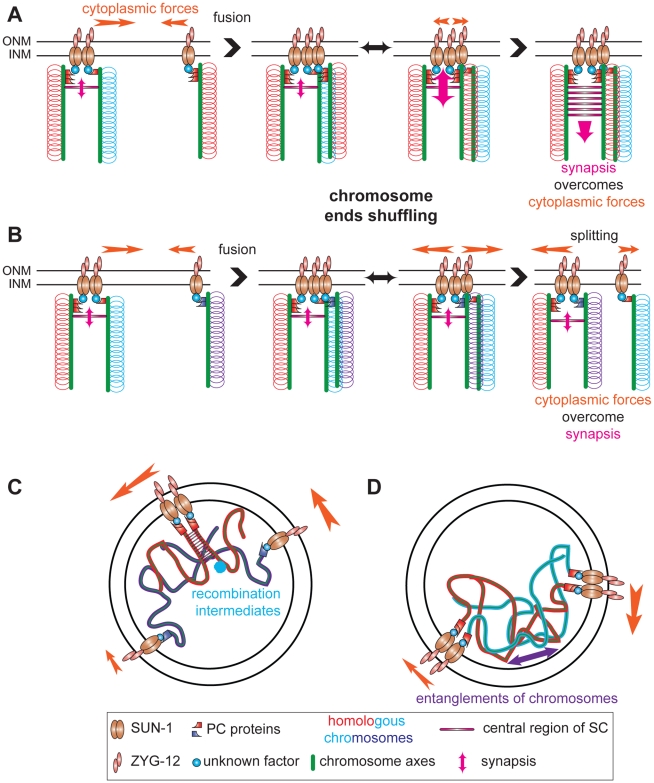
Establishment of synapsis and formation of high speed via shuffling of chromosome ends through SUN-1 patches.Chromosome axes (green lines) support binding of PC proteins (red or violet shapes) that connect chromosome ends (red, blue, and violet loops) to SUN-1 (brown ellipses), directly or indirectly, (unknown factor, blue circle). ZYG-12 (pink ellipses) and SUN-1 bridge chromosomes to cytoplasmic forces (orange arrow) to move chromosome ends. (A) SUN-1 patch containing two nonhomologous chromosome ends (red and blue loops) fuses with SUN-1 focus carrying a single chromosome end, a homolog (red loops). After fusion, chromosome ends will be shuffled inside the newly formed SUN-1 patch. When the homologous chromosome is found, synapsis overcomes the cytoplasmic forces and synapsis can be established. (B) The same scenario is depicted, except that ends of nonhomologous chromosomes are in the SUN-1 aggregate (violet loops). After fusion, chromosome ends will be shuffled. However, as the cytoplasmic forces overcome the attempt to synapse, one SUN-1 focus will be driven out of the patch. This tension-generated splitting event is one of the factors leading to the formation of high speed in the distribution of SUN-1 aggregates. Our data support other factors as sources for the high speed aggregates: recombination intermediates (C) and chromosomes entanglements (D).